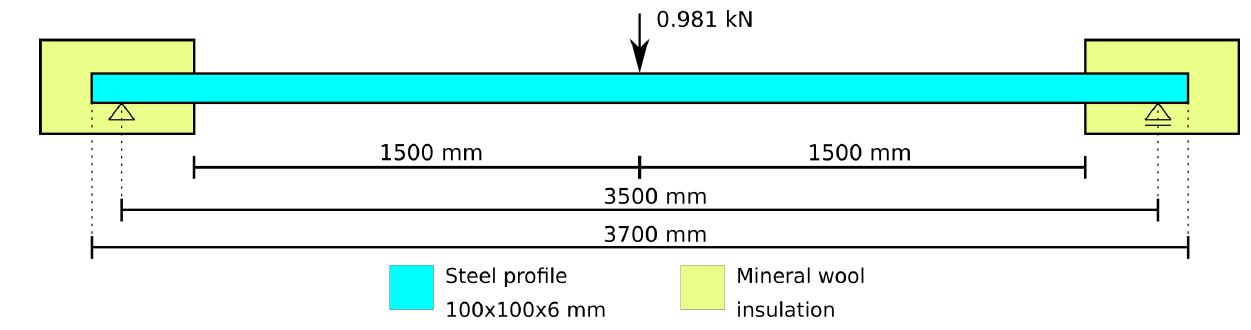
Figure 3. Geometry of the task, depicted unprotected beam.